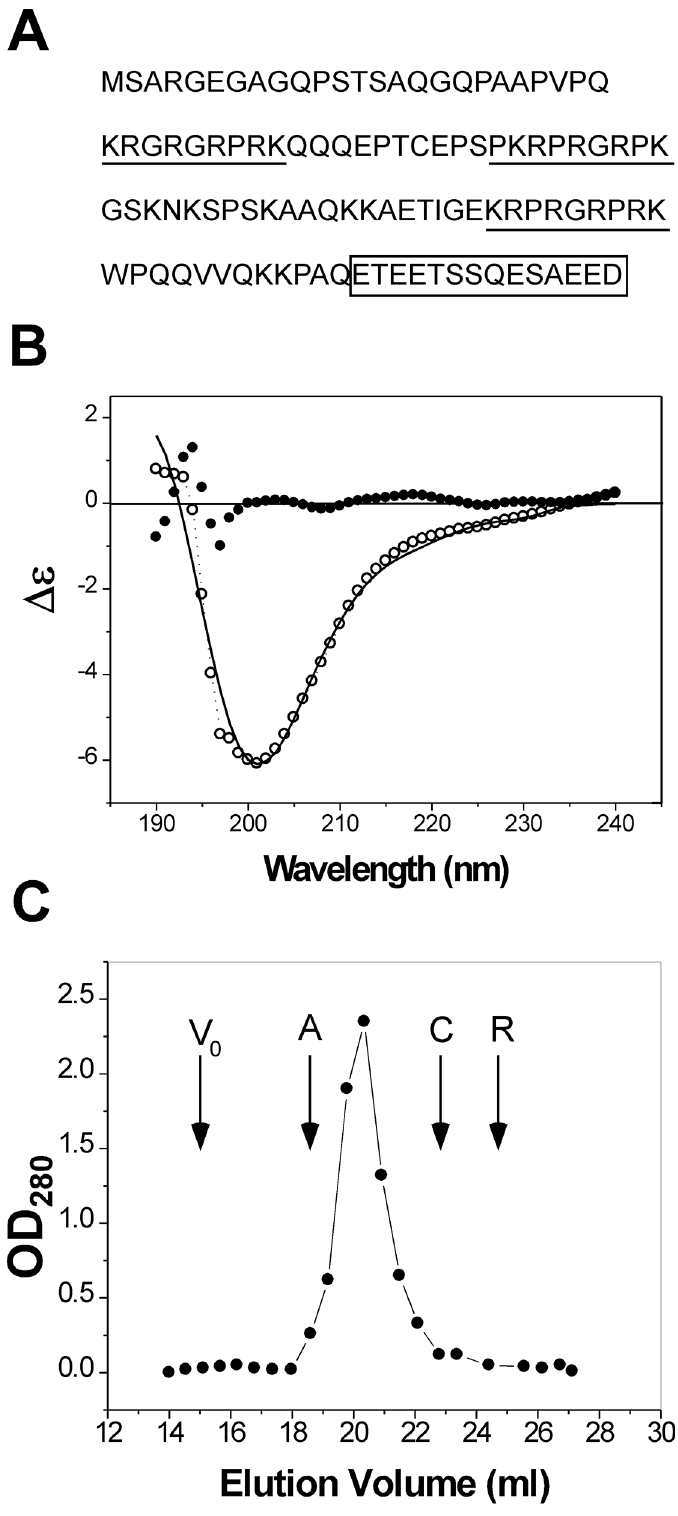
Fig 1. (A) Amino acid sequence of mouse HMGA2. The positively charged “ AT hooks ” and the negatively charged C-terminus are highlighted by underlines and a box, respectively. (B) The experimental (open dots with dotted line) and calculated (solid line) CD spectra of HMGA2 in BPES buffer. The CD spectra were